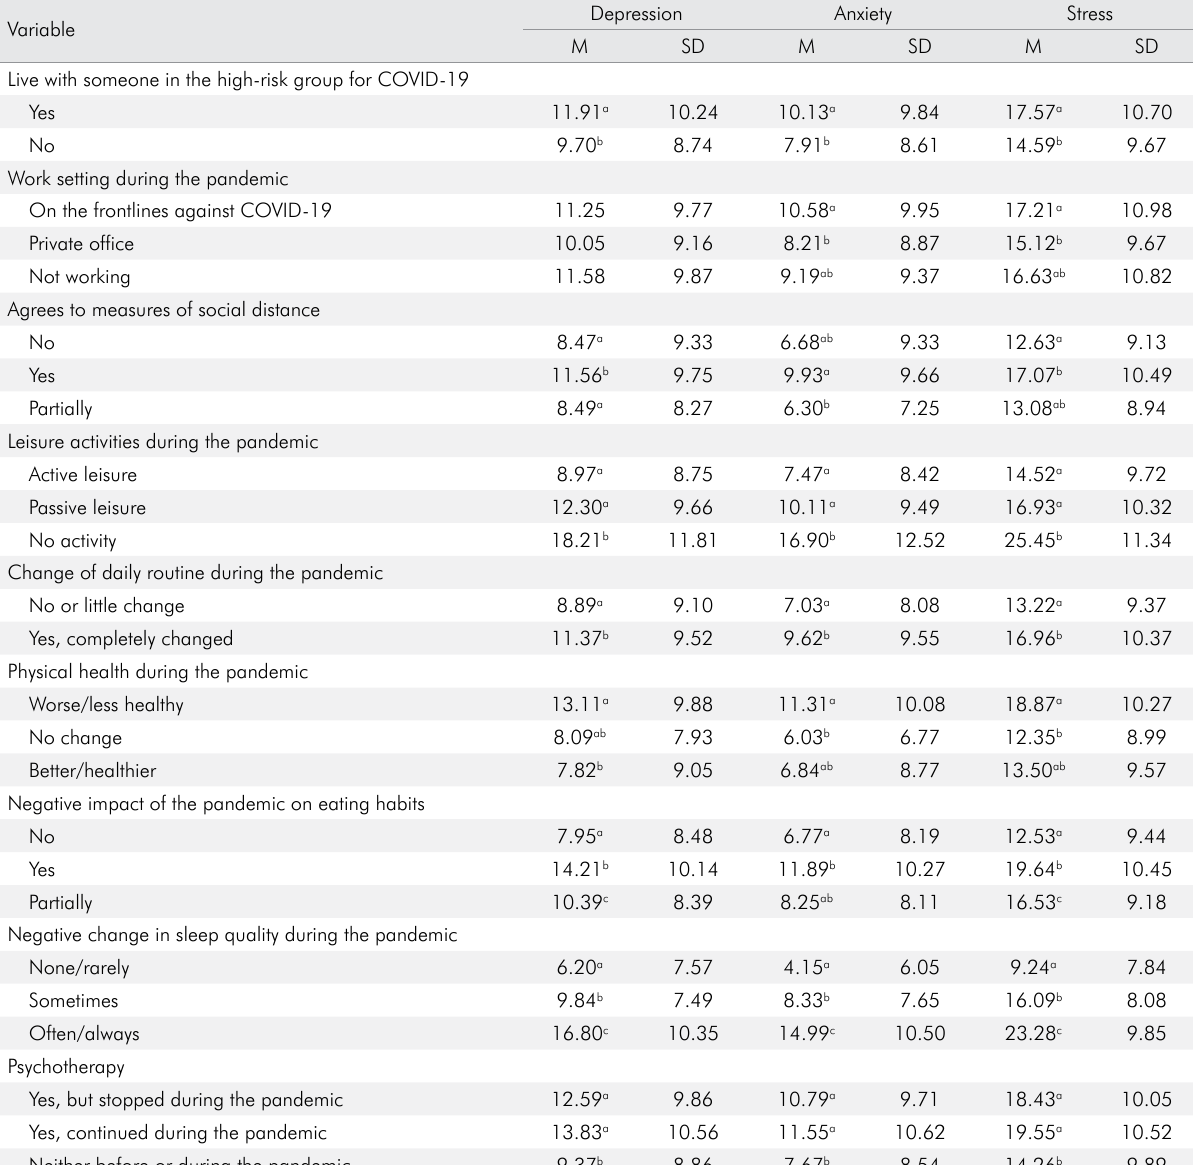
Table 5. Means and standard deviations of the scores for depression, anxiety, and stress in Brazilian dental surgeons due to factors related to the COVID-19